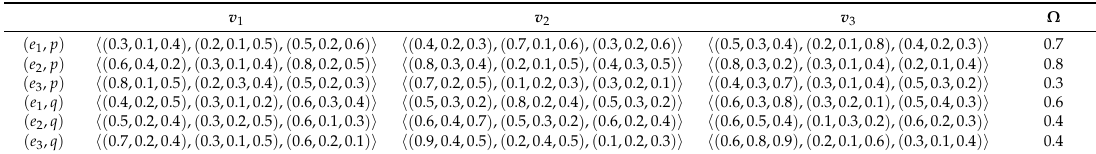
Table 1. Agree-neutrosophic soft expert